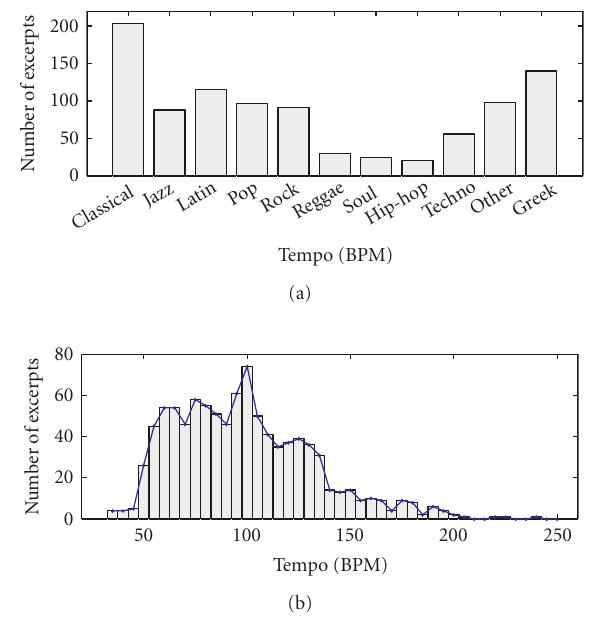
Figure 9: Dataset information. (a) The genre distribution in the database and (b) ground-truth tempi